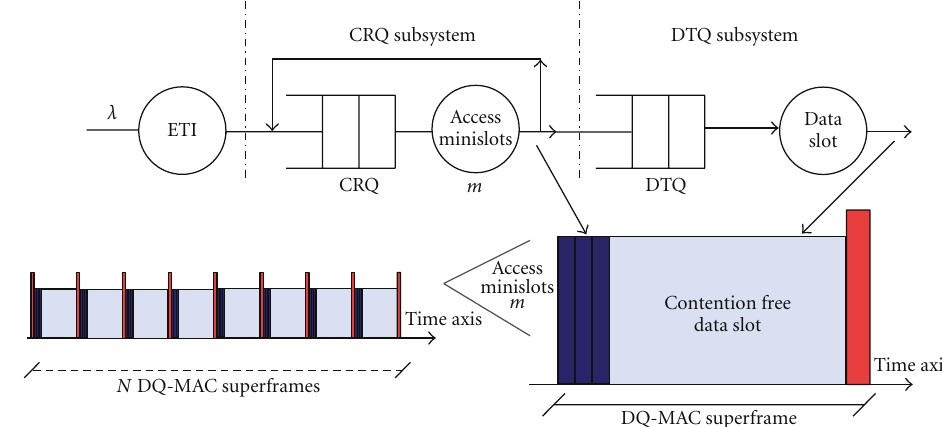
Figure 4: DQ-MAC system model and superframe